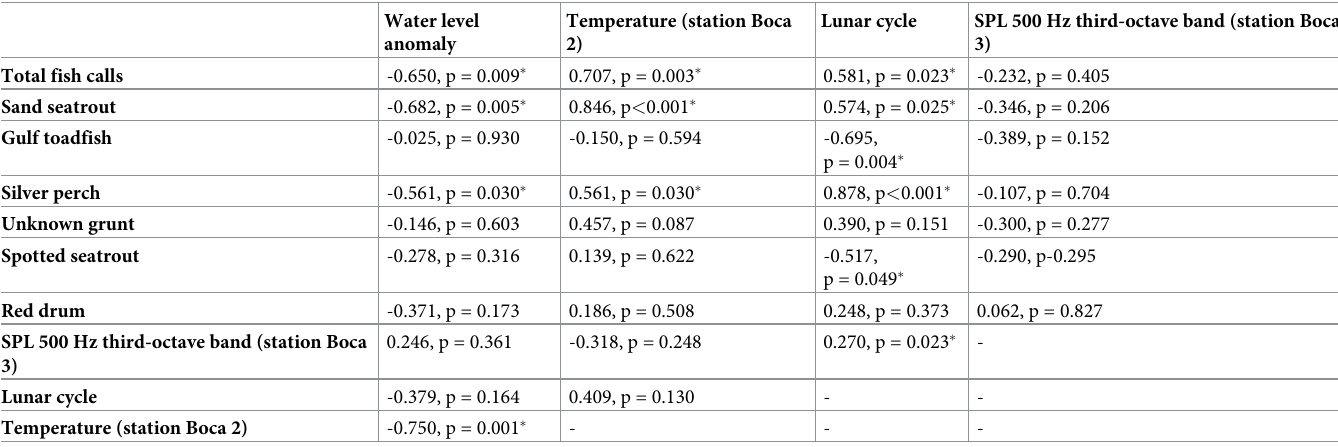
Table 7. Spearman’s rho correlations for station Boca